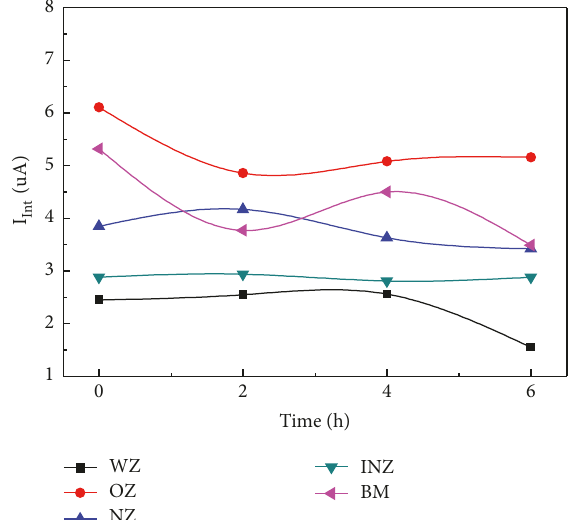
Figure 6: The current peak of anodic (i A , max ), cathodic (i C , max ), and the average current density (i Ave ) in SVET maps.